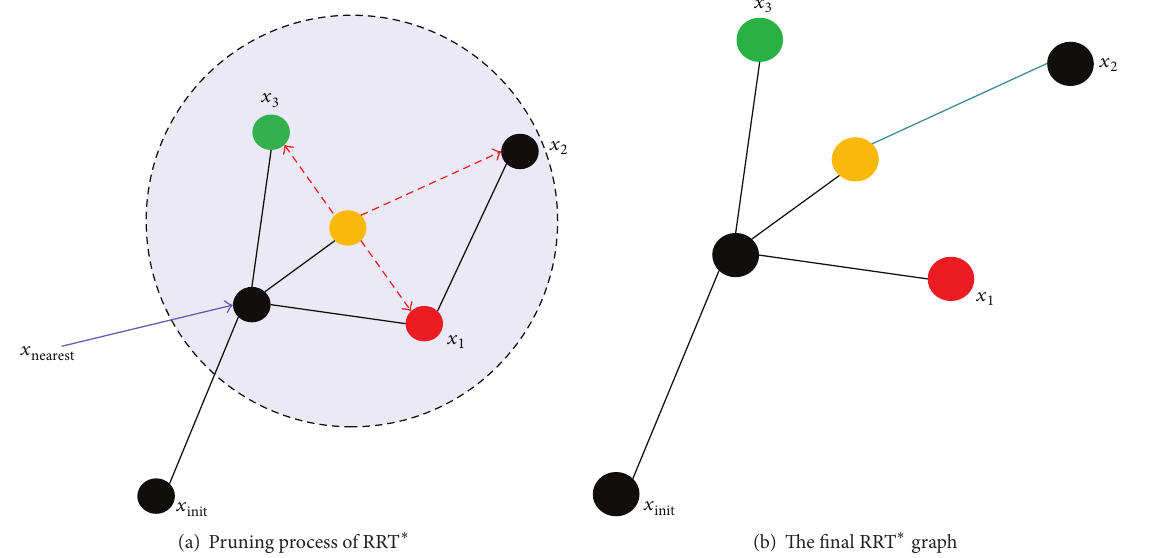
Figure 10: RRT ∗ postrefining process, that is, pruning of heavy connect.